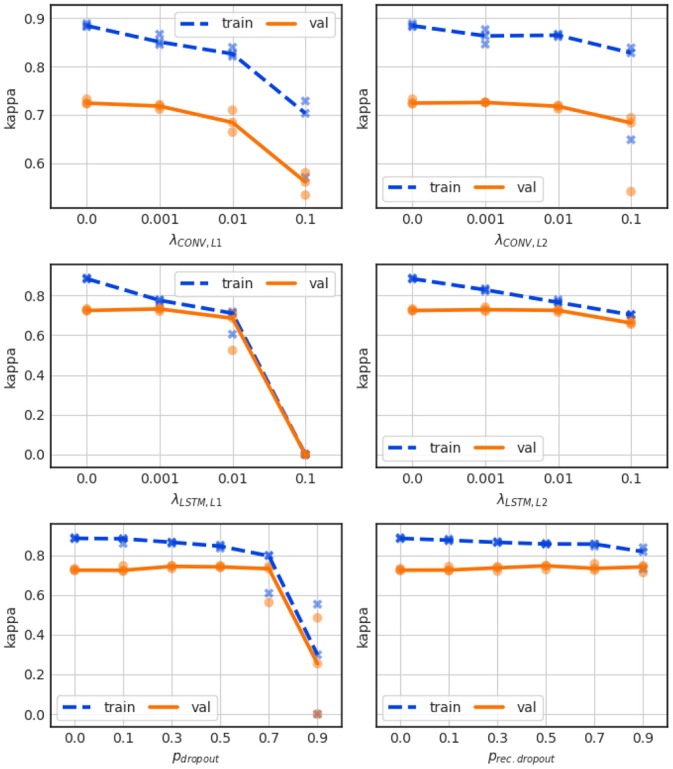
Influence of L1 penalty (top left) and L2 penalty (top right) for the convolutional layer weights, as well as for the LSTM layer weights (center left and center right). Influence of dropout for the LSTM layer forward paths (bottom left) and for recurrent paths (bottom right).